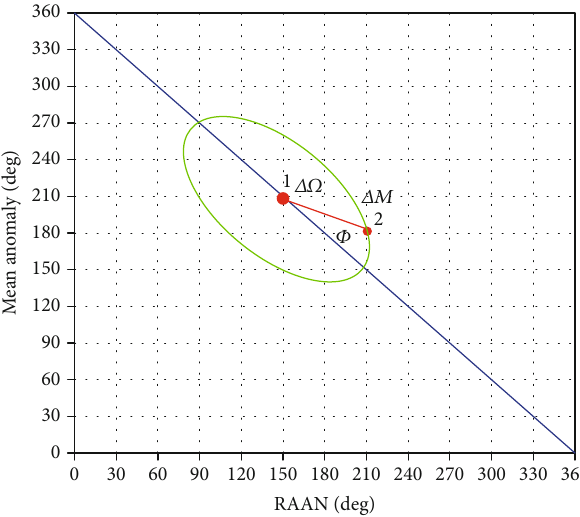
Figure 22: The most e ff ective range of crosslinks between two neighboring